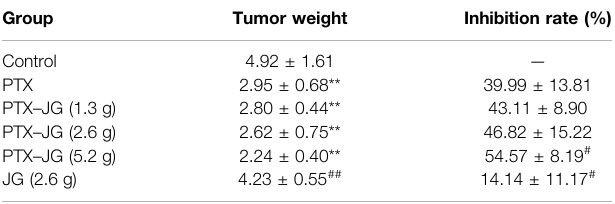
TABLE 3 | Effect of combination of JG with PTX on tumor inhibition.